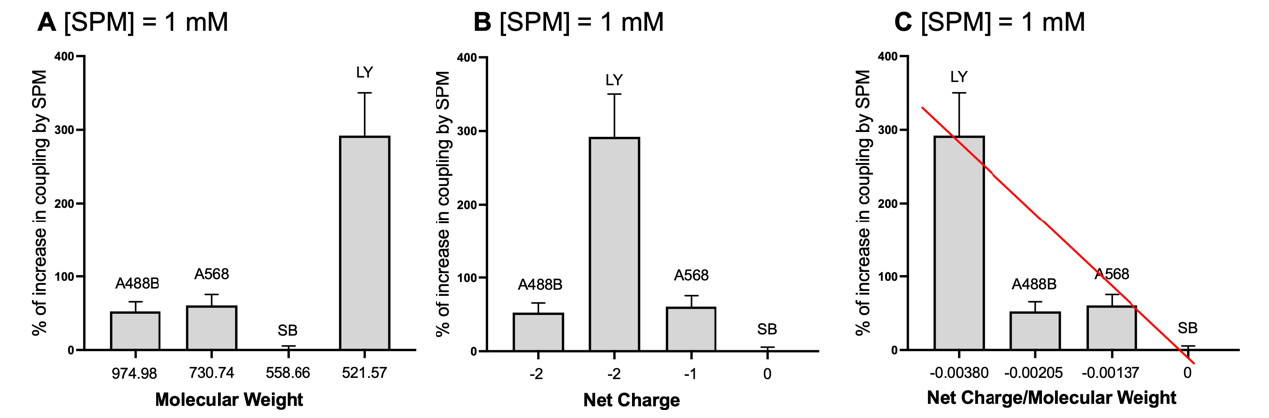
Figure 6. Spermine strongly increases propagation of negatively charged molecules: Dependence of the % increase in astrocytic coupling by SPM (1 mM) on the characteristics of the individual dyes. SPM-induced a 56% increase in the Alexa 488-biocytin group, a 61% increase in the Alexa 568 group, no change in the Sulforhodamine B group and a 292% increase in the Lucifer Yellow group. These changes were dependent on ( A ) molecular weight of the dye, ( B ) net charge of the dye and correlate ( C ) with the ratio of net charge and molecular weight of the dye. The red line shows the strength of SPM to increase propagation of various negatively charged molecules through GJs in the astrocytic syncytium. Error bars indicate standard error of the mean (SEM). Note: compare with Figure 4 where endogenous PAs were dialyzed out of the astro- cytes.